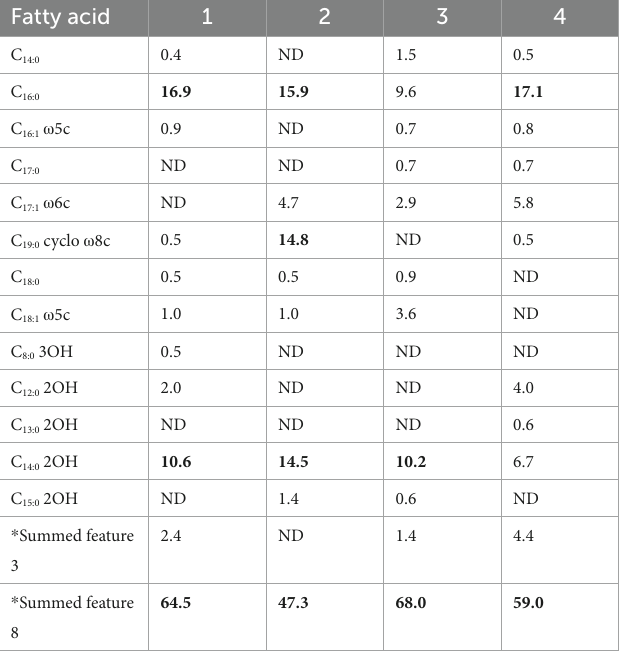
* Summed features are groups of two or three fatty acids that cannot be separated by GLC with the MIDI System. Summed feature 3 contains C 16:1 ω 6c or/and C 16:1 ω 7c. Summed feature 8 was listed as C 18:1 ω 7c or/and C 18:1 ω 6c. Values are percentages of total fatty acids. ND, not detected. The major components (> 10%) are shown in bold. Strains: 1, Sphingomonas nostoxanthinifaciens AK-PDB1-5 T ; 2, S. crusticola KCTC 42801 T ; 3,